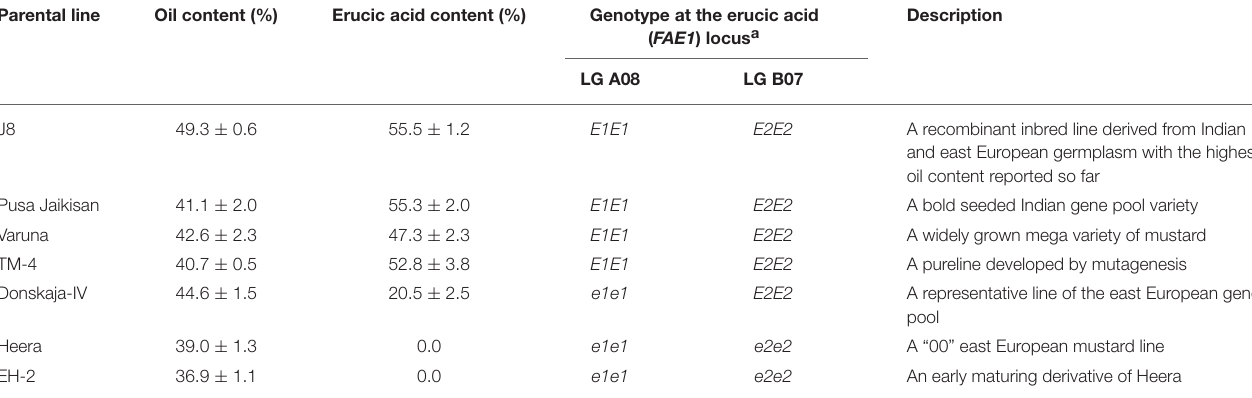
TABLE 1 | Phenotypic variation for oil content and erucic acid in seven parental lines used for developing the five bi-parental mapping populations. Parental